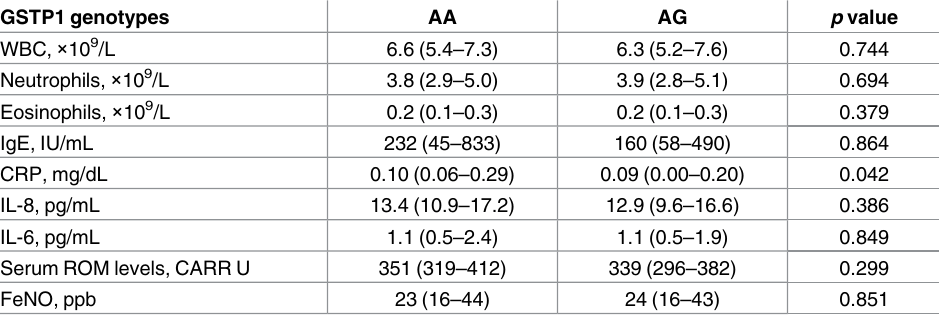
Table 4. Biomarkers and Serum ROM Levels in Exon 5 Polymorphism of GSTP1